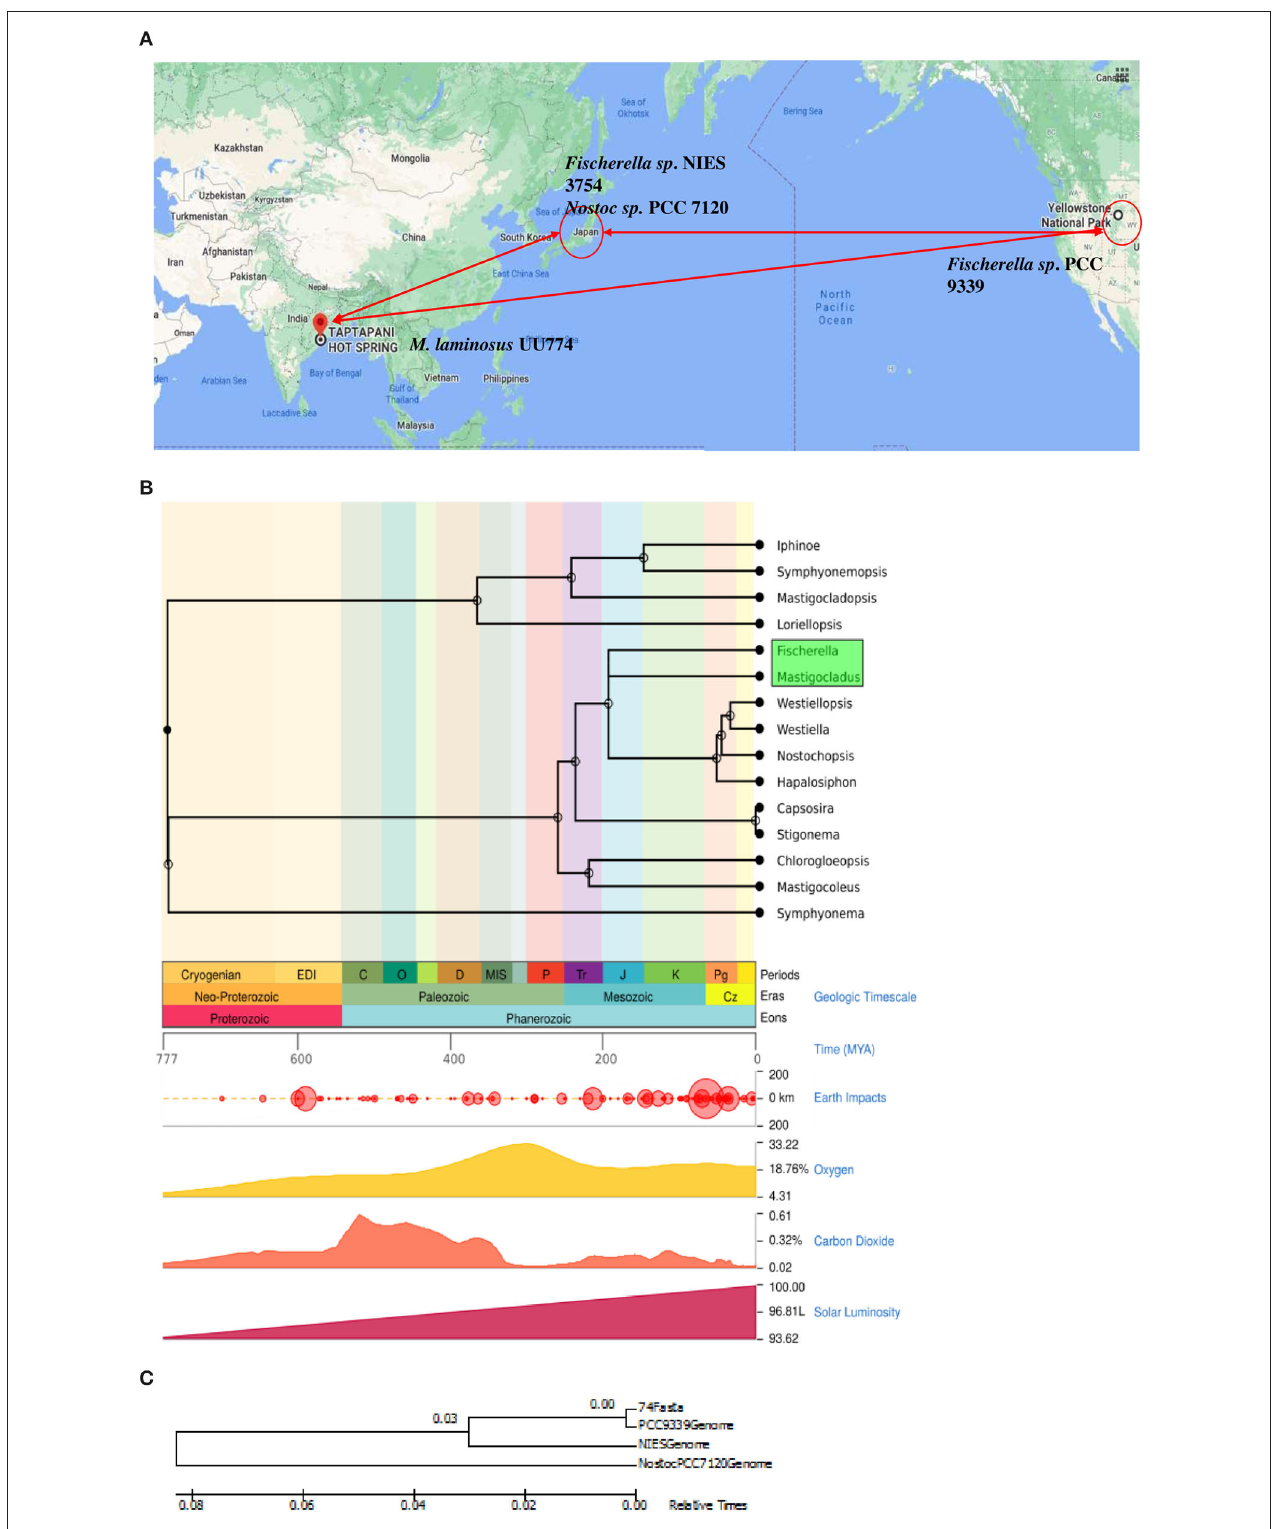
FIGURE 1 | (A) Geographical location of the strains used in this study. The map was generated using google maps software (Google, n.d.). Mastigocladus laminosus UU774 was isolated in Eastern India and sequenced and analyzed by us, whereas the genomic data of PCC 9339, PCC 7120, and NIES-3754 were